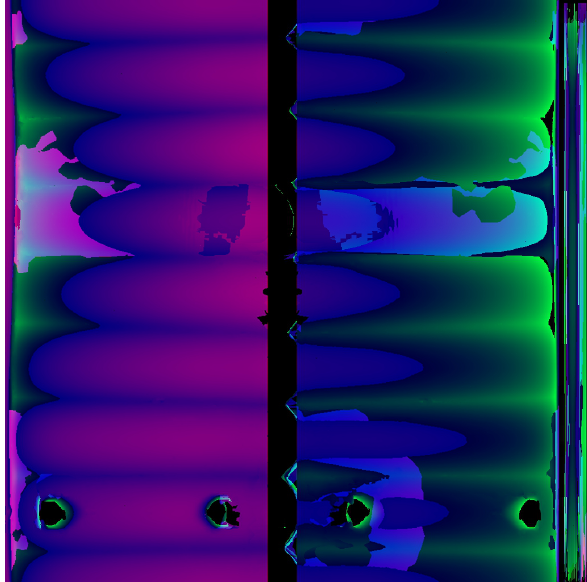
Figure 2: This is the distance texture of a cup with an orthogonal footprint. One can identify eight repetitions of (more or less) the same